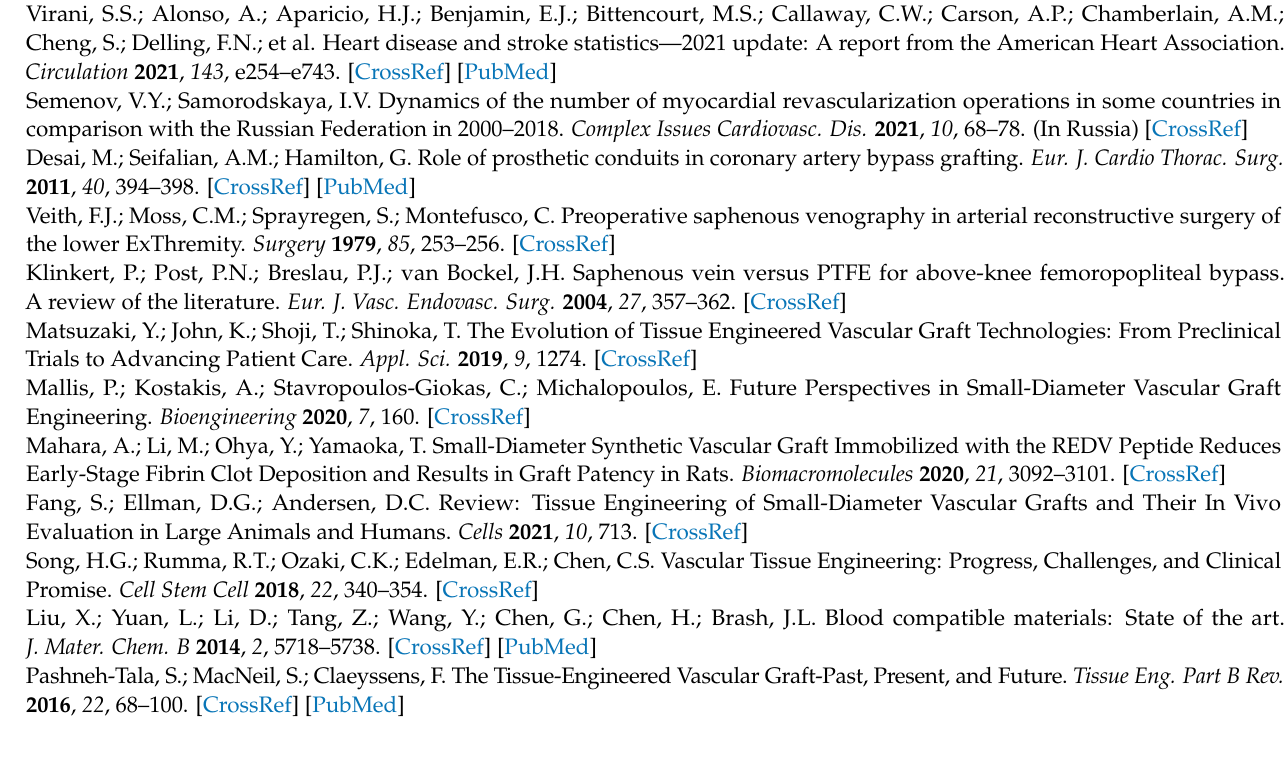
thrombin; Figure S2: Biological properties of fibrin matrices prepared at fibrinogen concentrations of 20 and 30 mg/mL using endogenous (EnThr) and exogenous (ExThr) thrombin; Figure S3: Thrombin generation assay (TGA)